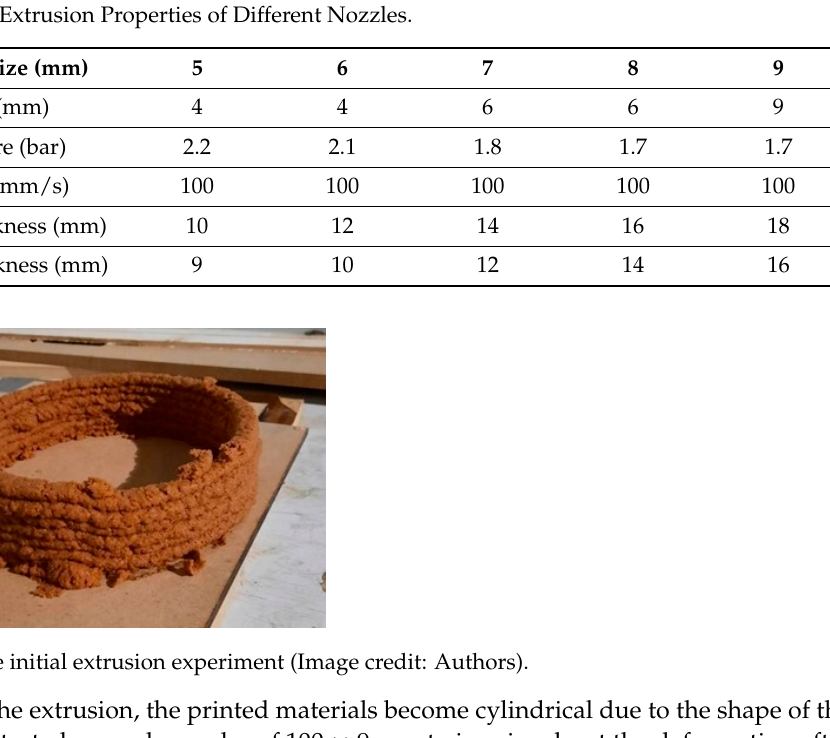
Figure 8. The Fabricated Extruder (Image credit: Authors).